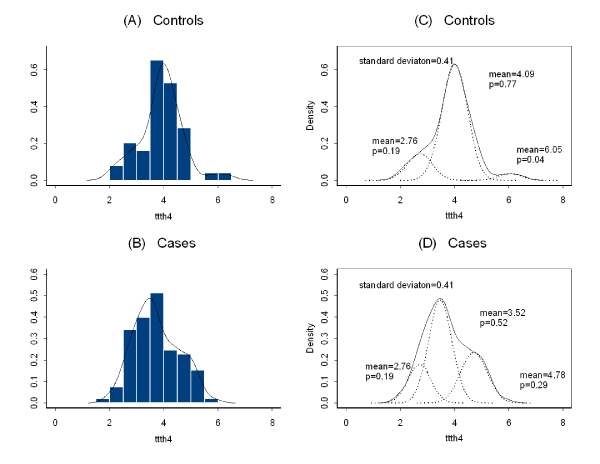
Density polygons for alcohol-related trait ttth4: cases vs. controls.